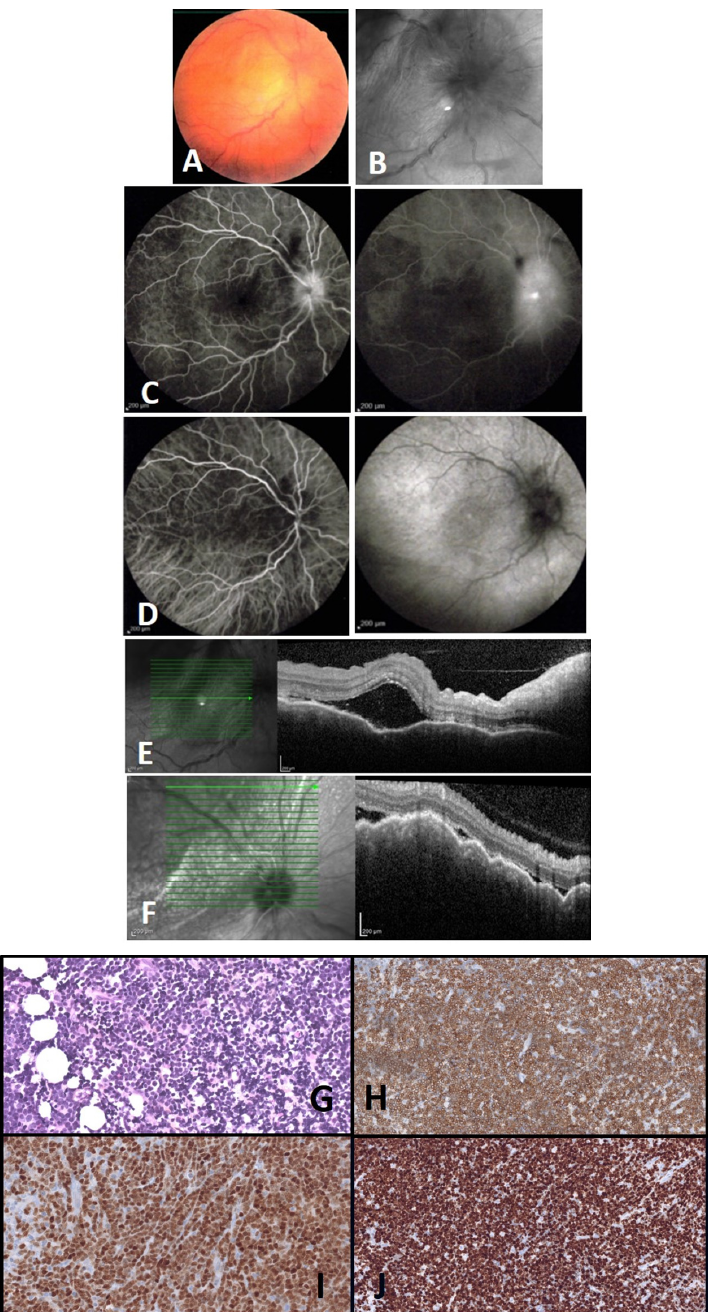
Figure 1. ( A – F ). Case 1. ( A ) Right eye color fundus ( B ) and red-free photographs showing a papilledema; ( C ) Early (on the left) and late (on the right) frame of fluorescein angiography showing dye leakage from the optic nerve; ( D ) Indocyanine green angiography early (on the left) and late (on the right) frames showing no obvious choroidal lesion; ( E ) Initial SD-OCT (Heidelberg) showing choroidal folds and localized subretinal fluid; ( F ) At two weeks, SD-OCT (Heidelberg) showing worsened choroidal folds and subretinal fluid. ( G – J ). Case 1. Histopathology and immunohisto- chemistry of a periocular biopsy; ( G ) Infiltration by lymphoblasts with round and irregular shaped nuclei (HES × 200); ( H ) Cd3 staining shows cytoplasmic positivity (CD3 clone NCL-L-CD3-565, ×200); ( I ) TdT staining highlights intense nuclear positivity (clone Novocastra NCL-L-TdT-339, ×200); ( J ) MIB1 antibody staining for Ki67 highlights very high proliferation rate (clone M7240, dako, ×200).